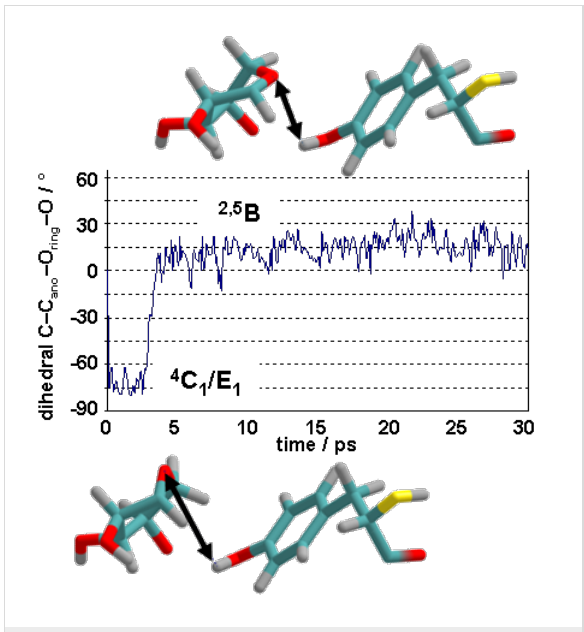
Figure 5: Conformational change of the xylose ring from chair (via envelope) with long O Y H Y… O ring hydrogen bond to boat with short hydrogen bond, as shown by QM/MM MD simulation in active site of BCX.